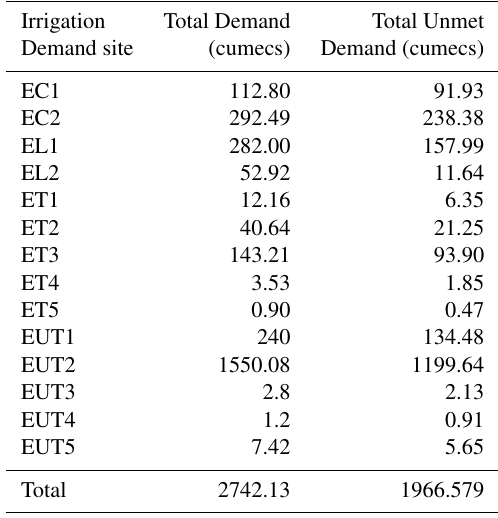
Table 1. 2015/2016 hydrologic year total demand and unmet de- mand for